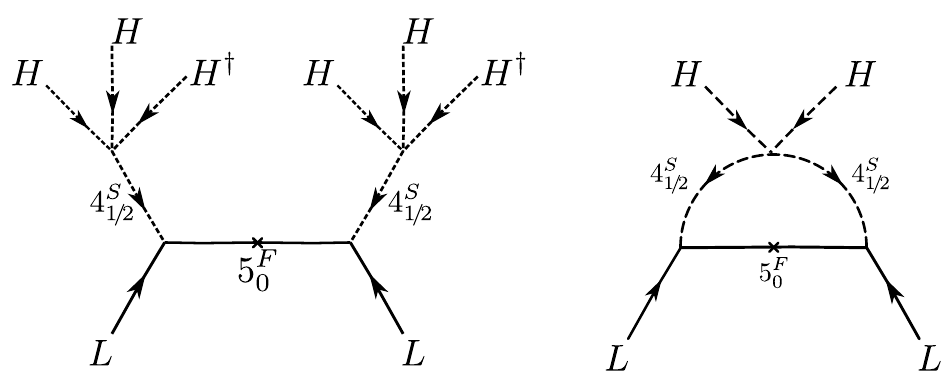
Figure 5 . One example of a \non-genuine" d = 9 diagram, to the left. Connecting the two quadruplet scalars, as shown on the right, leads to a 1-loop diagram at d = 5. corresponds to imposing the condition that the mass squared parameter of the new scalar doublet is positive, (cid:22) 2 > D